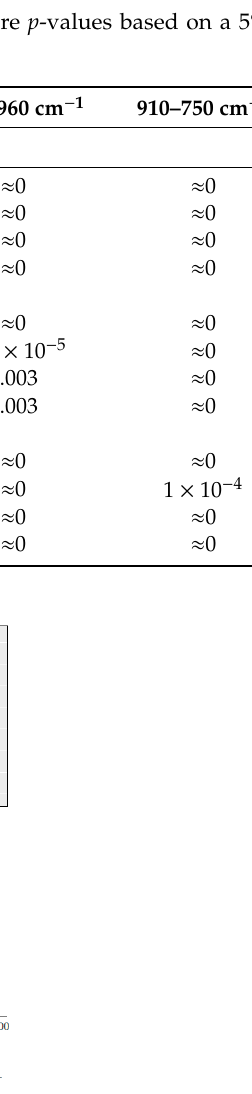
Figure 3. Plots of two of the four significant areas of the curves with an ageing time of 18 months. In the first row, vectorial analysis by means of boxplots. In the second row, functional data analysis (FDA) through curves in the studied interval. The wine spirit sample is divided into four groups (AC, AL, TC, and TL).